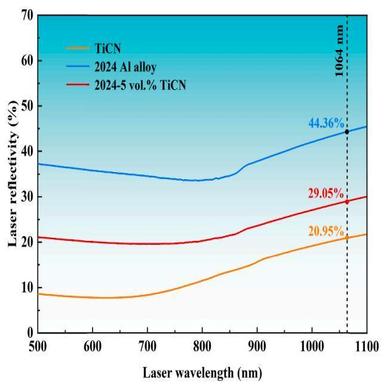
Laser reflectivity of TiCN, 2024 Al alloy, and 2024-5 vol% TiCN composite powders.